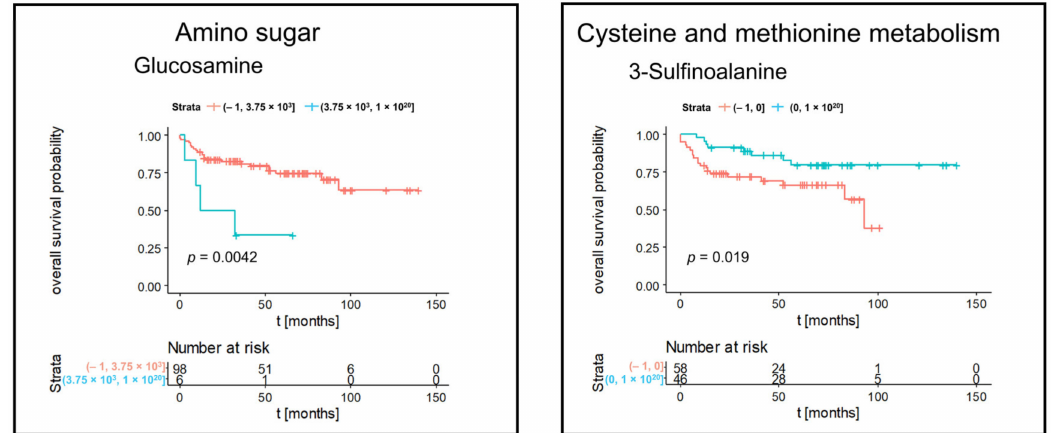
Figure 7. Kaplan–Meier significant metabolites specific for subtype pRCC. Blue lines indicate survival in patients with high intensity of the respective mass. Red lines indicate survival in patients with low intensity of the respective